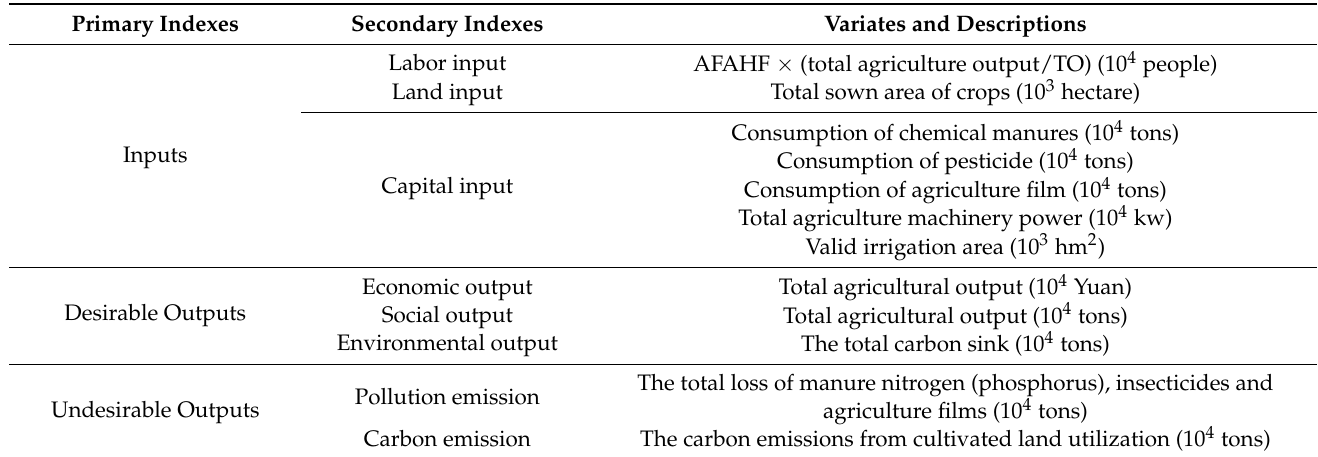
Table 1. The indicators used to measure